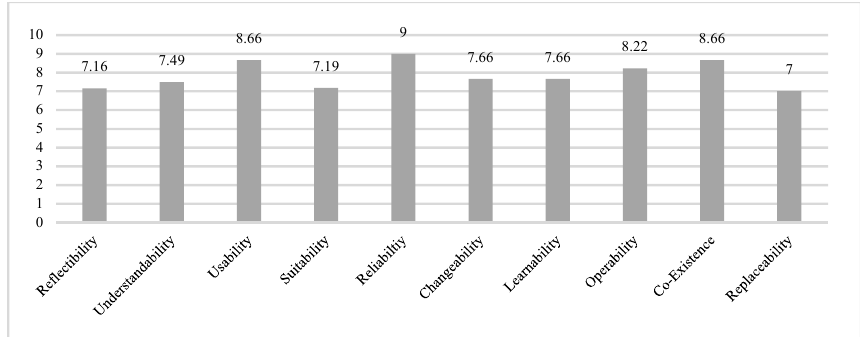
Figure 19. Average of each software quality characteristic.